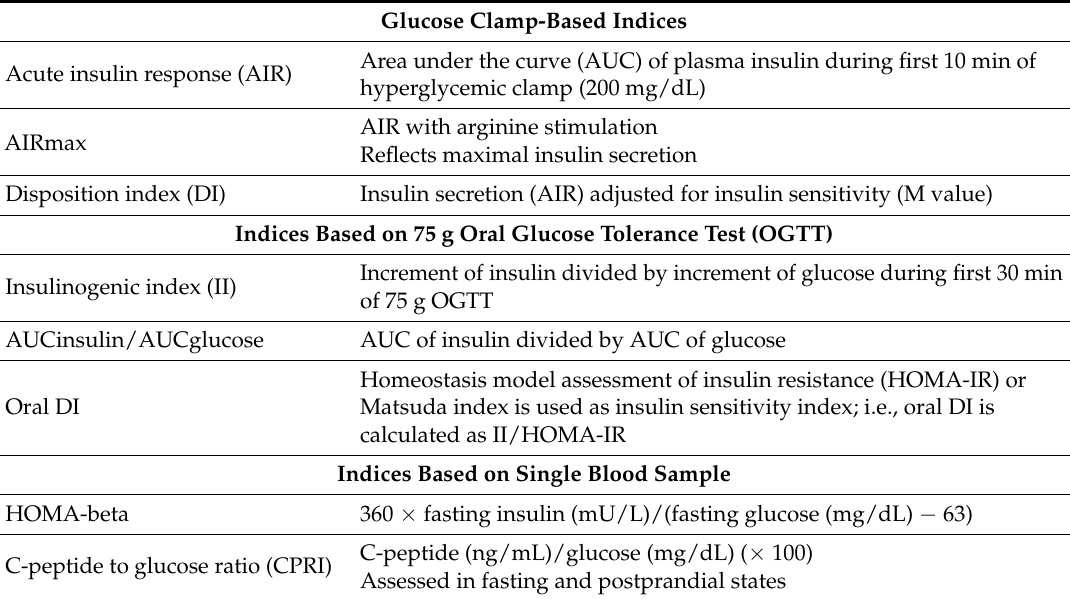
Table 1. Indices of beta cell